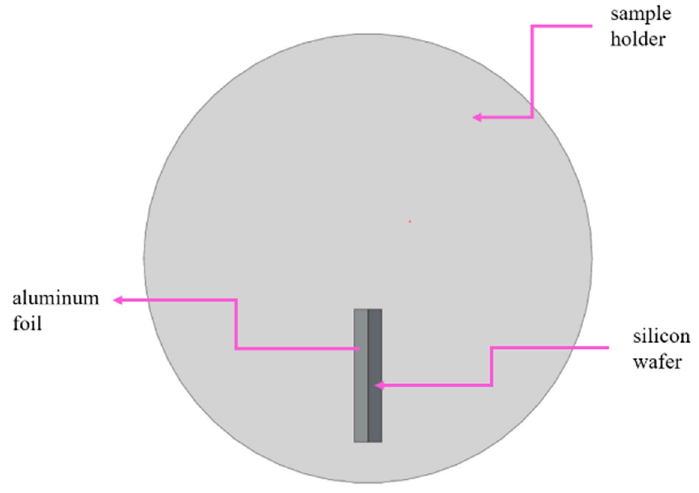
Figure 9. Step shielding mode.